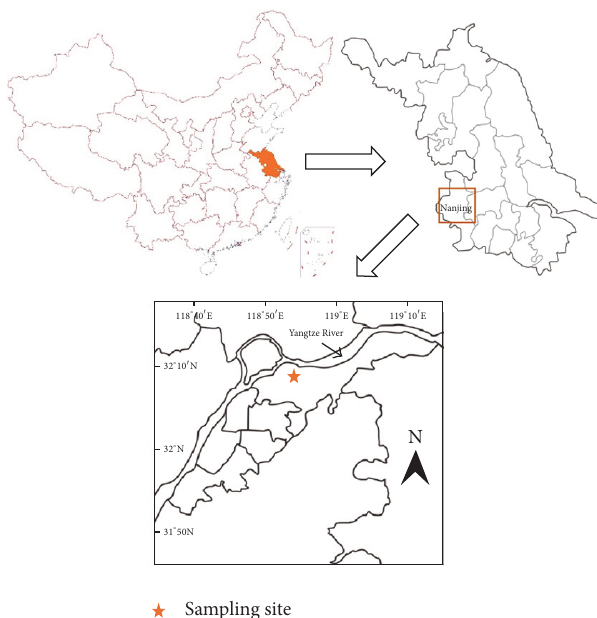
Figure 1: Sample location in Nanjing,